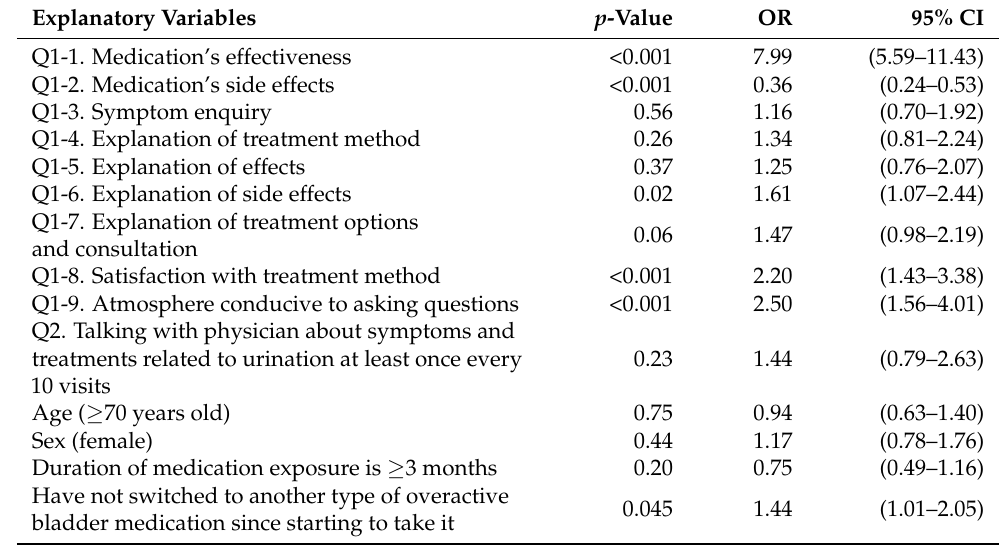
Table 2. Endpoint 1: Association with satisfaction with overall medical care for overactive bladder.